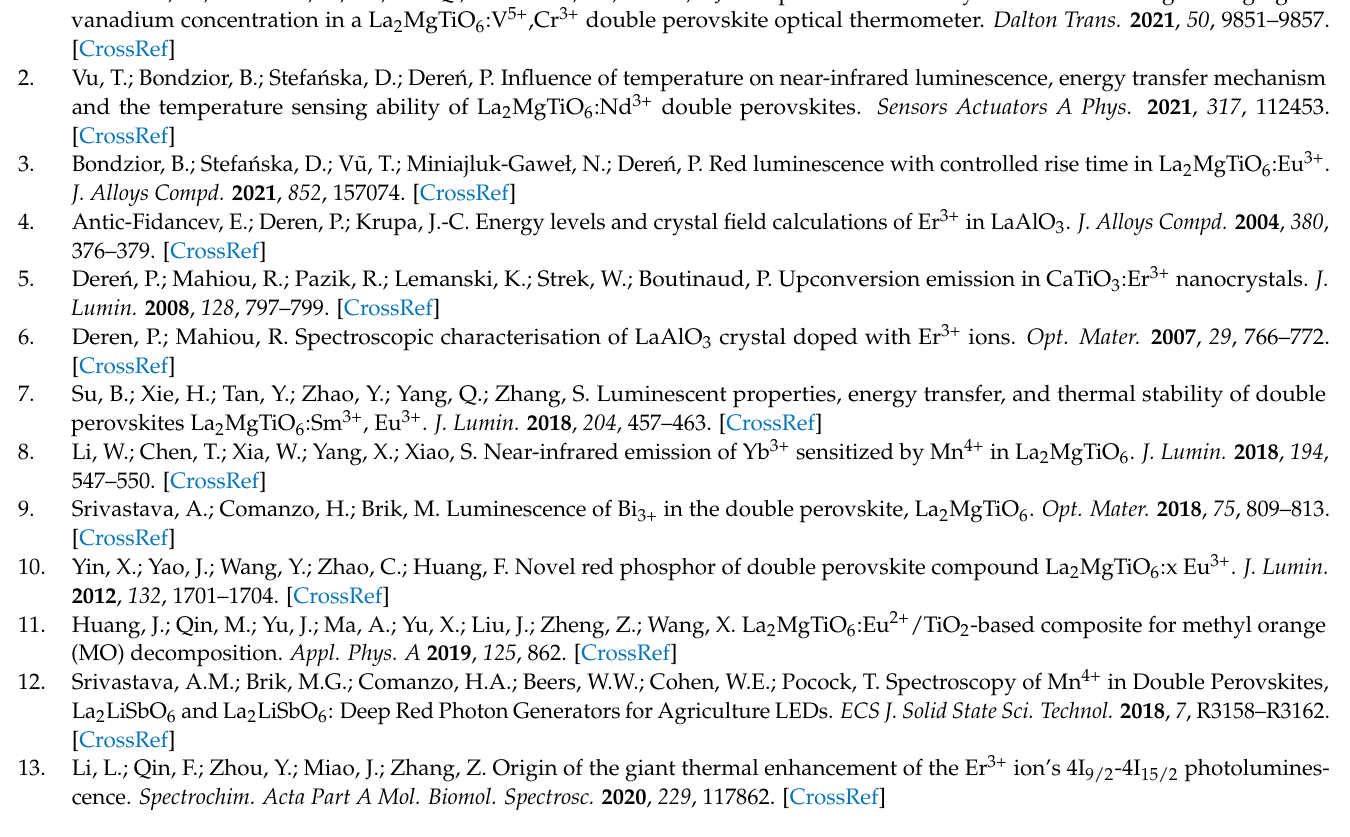
rise time (in the inset) excited at 266 nm and monitored at 549 nm (a), at 662 nm (b), at 988 nm (c). Figure S7: Energy transfer rates Wtot = aCn at 300 K as a function of Er 3+ concentration. Figure S8. Thermometric parameters (a) and absolute sensitivities, Sa (K-1) (b) based on thermally coupled levels; Thermometric parameters (c) and absolute sensitivities, Sa (K-1) (d) based on thermally uncoupled levels. Table S1: Energy levels of Er 3+ ions in La 2 MgTiO 6 double perovskites obtained from the 77 K and 300 K emission spectra and the 300 K absorption spectrum *. Table S2: Decay time of La 2 MgTiO 6 :Er 3+ obtained at different monitoring wavelength corresponding to 4S3/2 (549 nm), 4F 9/2 (662 nm), 4I 11/2 (988 nm) levels and their rise time (*) single-exponential decay for the sample La 2 MgTiO 6 :0.1% Er 3+